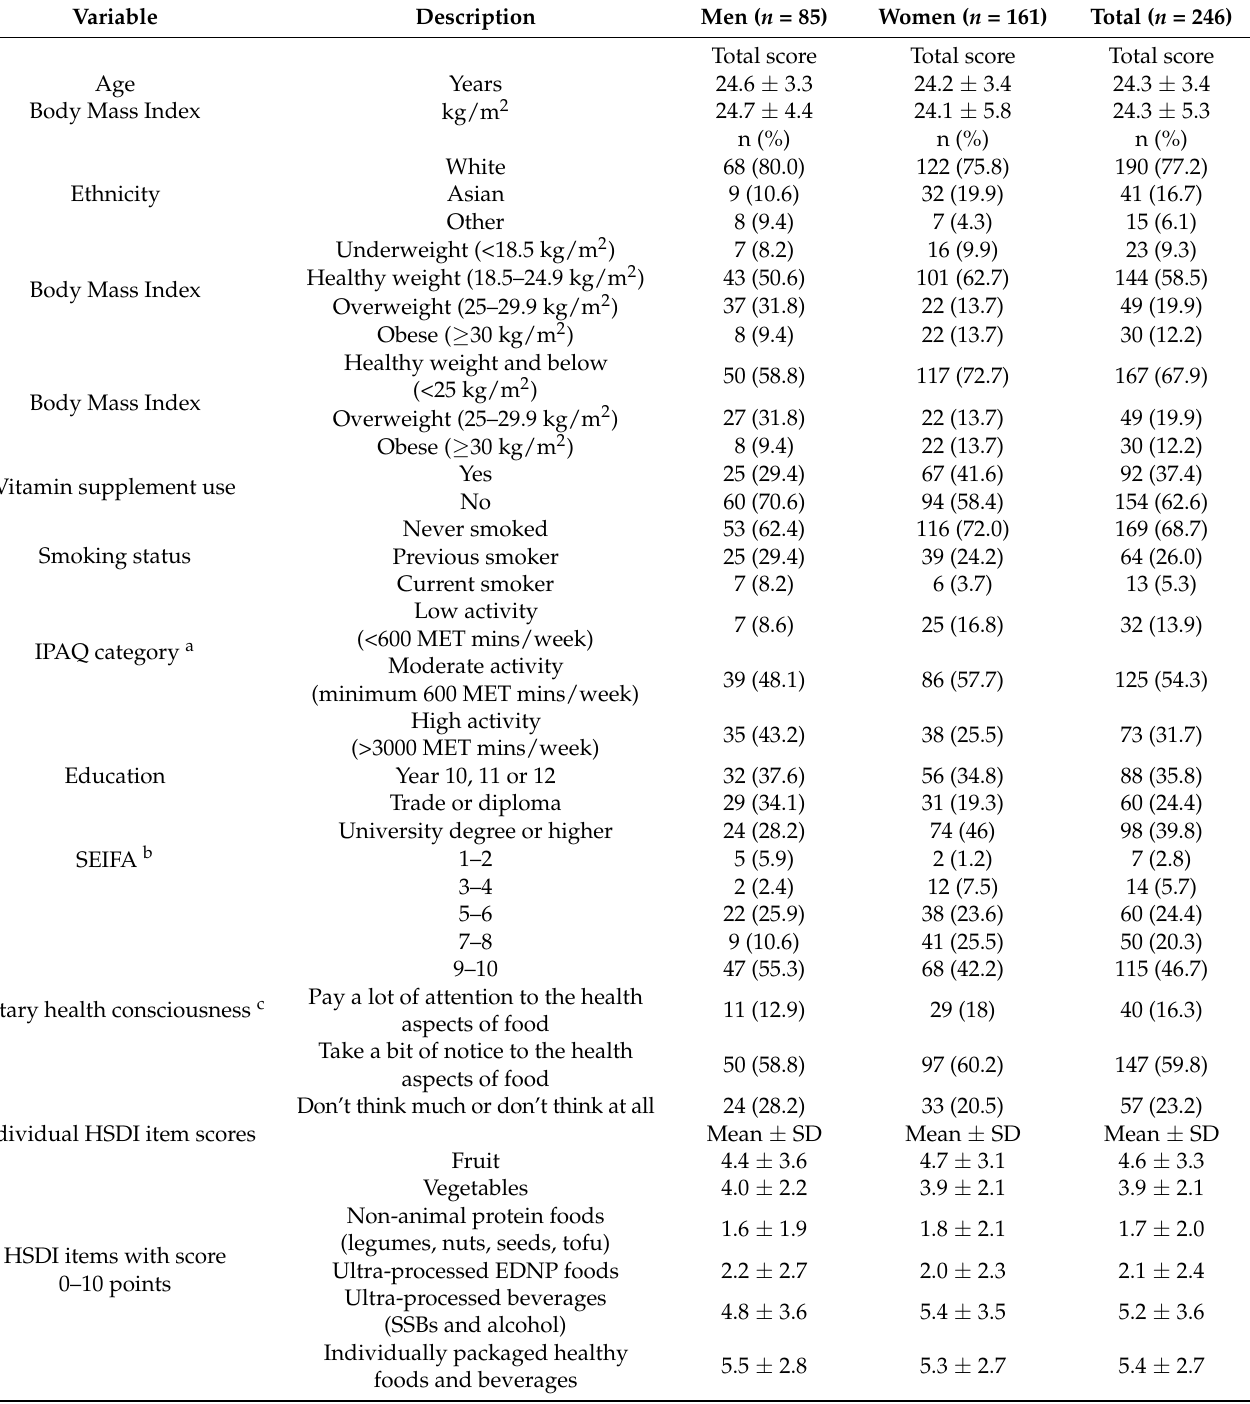
Table 2. Descriptive statistics of the study population and HSDI index scores * at baseline ( n =